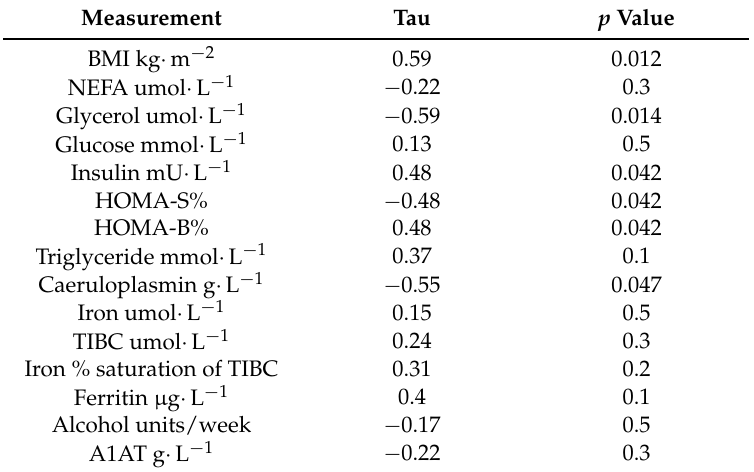
Table 1. Kendall Tau rank correlation between liver fat and metabolic parameters. Measurement